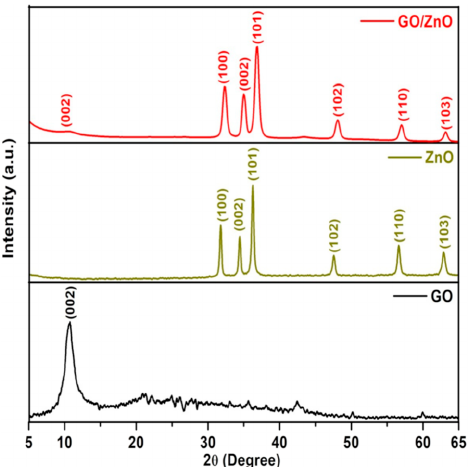
Figure 21. XRD pattern of as-synthesized graphene oxide and reduced graphene. Reproduced from [121] with permission from The Royal Society of Chemistry.